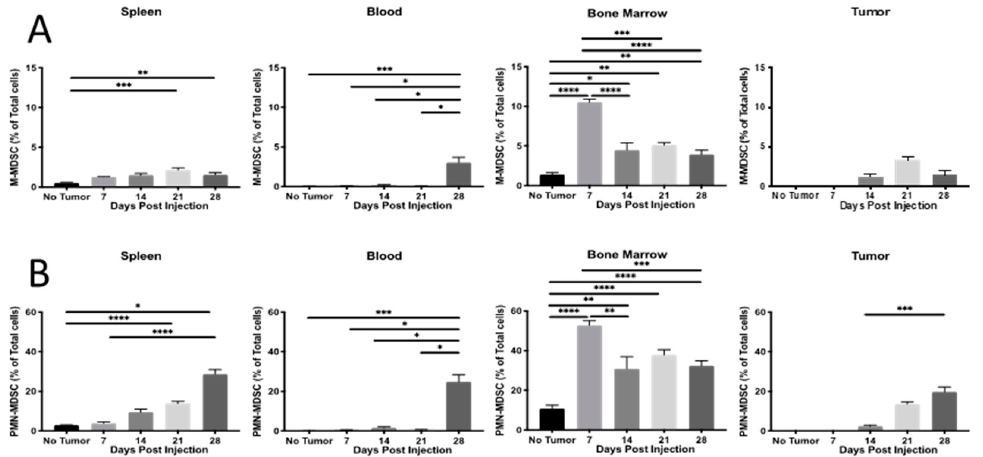
Figure 5. 4T1-WT mammary-tumor-induced MDSC expansion. Flow cytometric measurement of